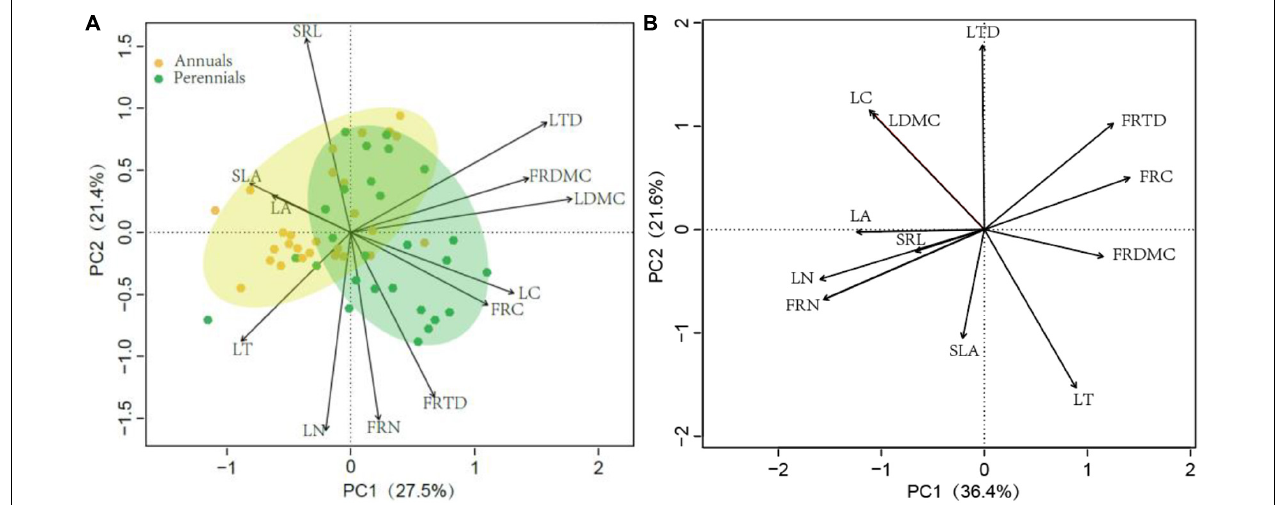
FIGURE 2 | Principal component analysis (PCA) on traits in 54 dominant species in Horqin Sandy Land. Data: (A) without and (B) with phylogenetically independent contrasts. LT, leaf thickness; LA, leaf area; LDMC, leaf dry-matter content; SLA, specific leaf area; LTD, leaf tissue density; FRDMC, fine root dry-matter content; SRL, specific root length; FRTD, fine root tissue density; LN, leaf nitrogen concentration; LC, leaf carbon concentration; FRN, fine root nitrogen concentration; FRC, fine root carbon concentration.